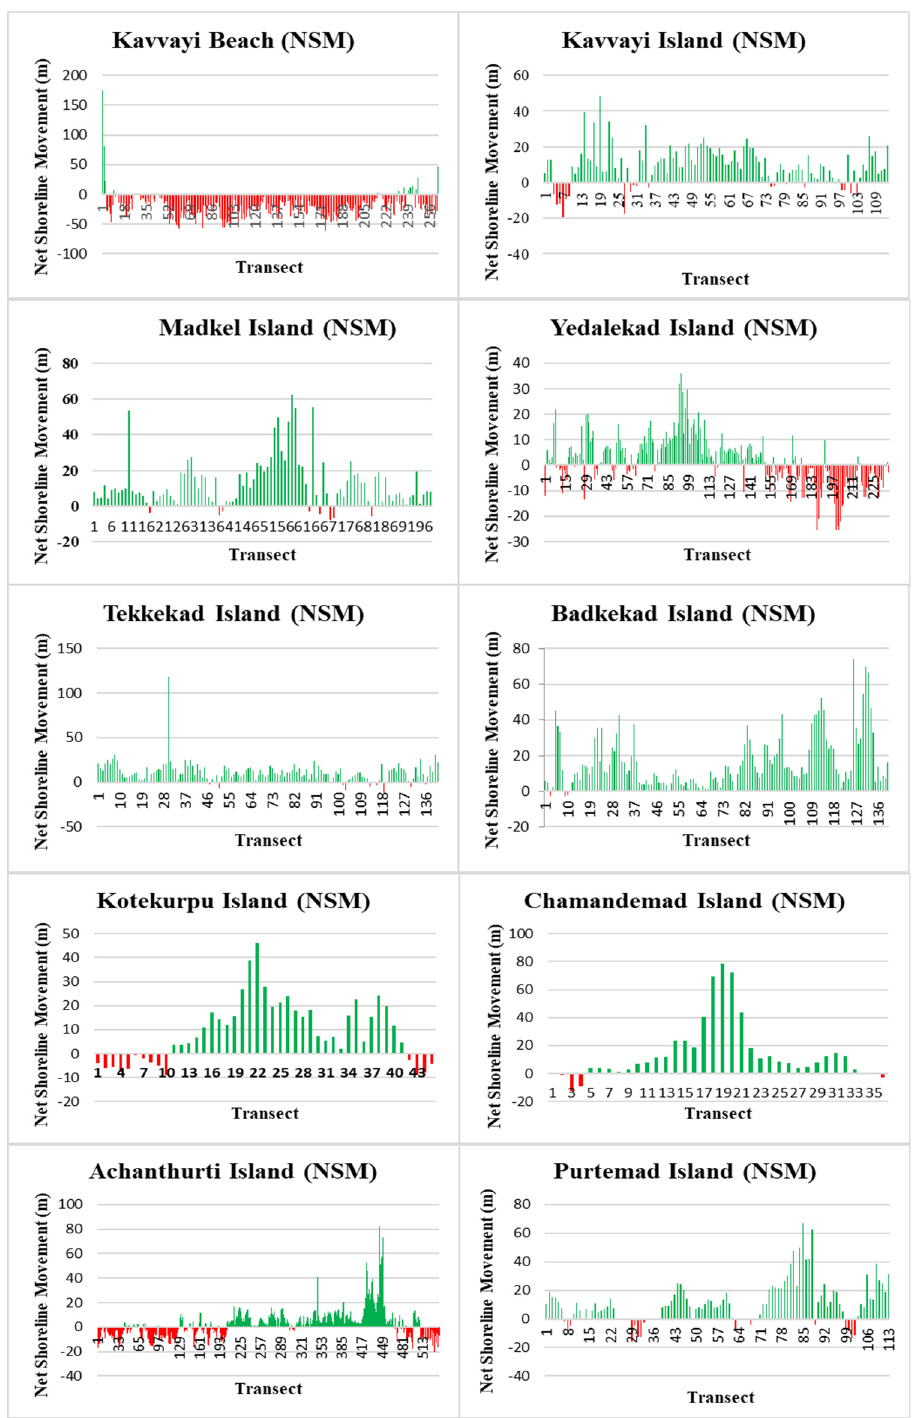
Figure 4. Bar graphs representing net shoreline movement of Kavvayi beach, Kavvayi island, Mad- kel island, Yedalekad island, Tekkekad island, and Badkekad islands of Kotekurupu island, Cha- mandemad island, Achanthurti island, and Purtemad island of Kavvayi wetland .